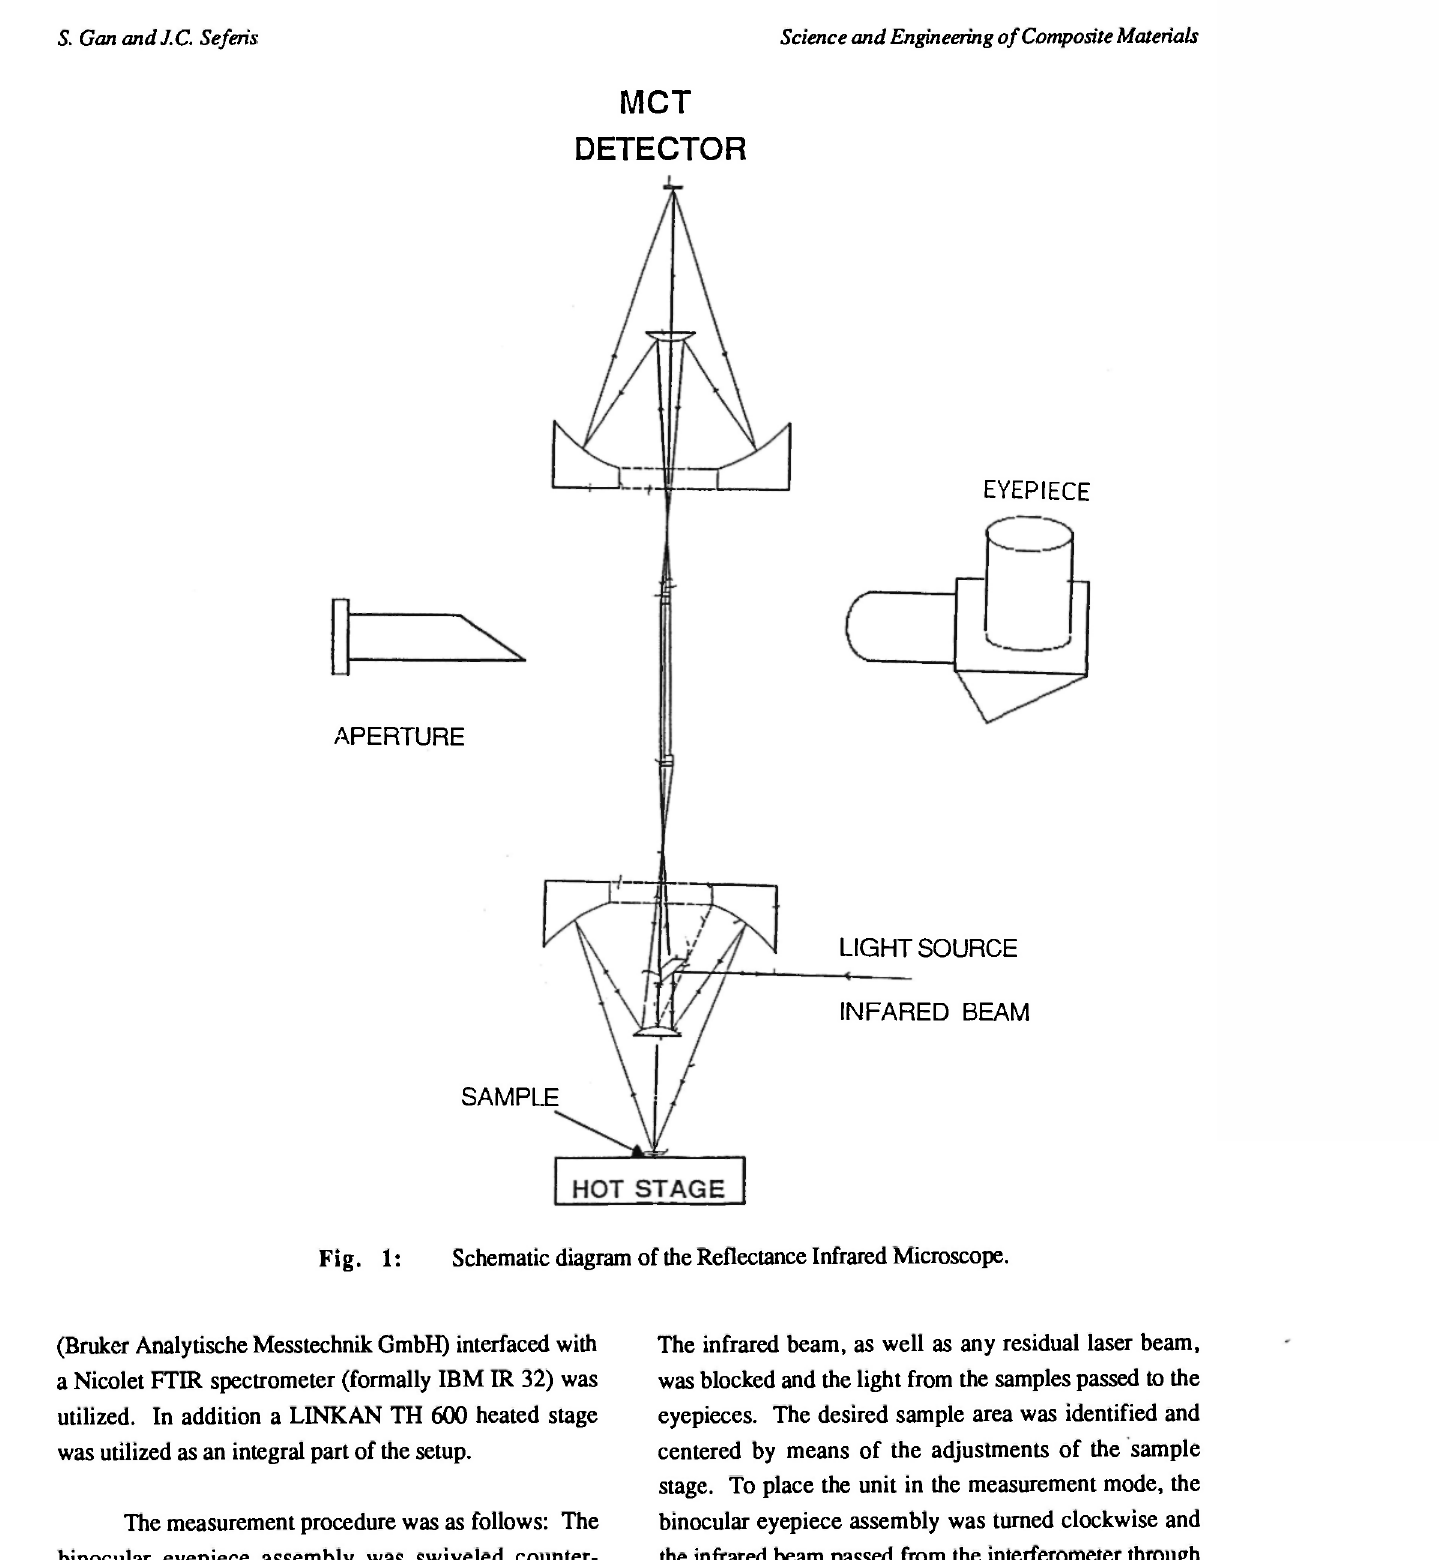
Fig. 1: Schematic diagram of the Reflectance Infrared